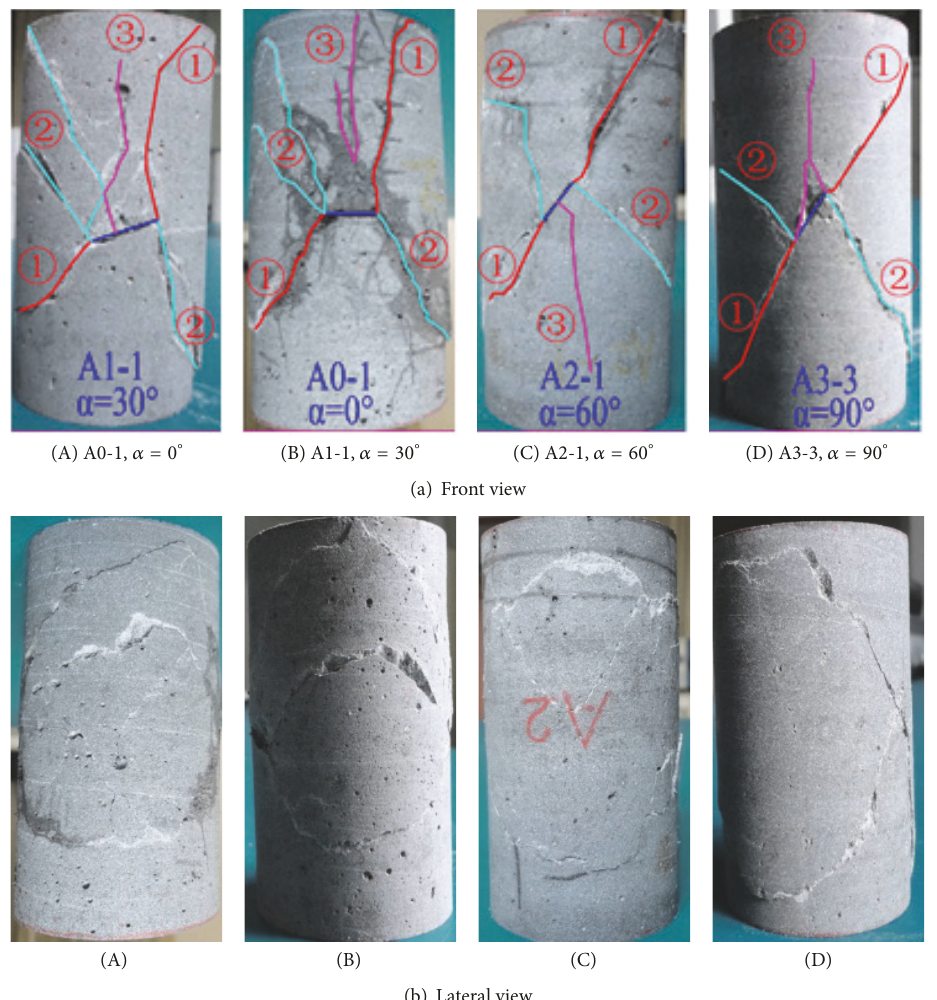
Figure 6: Fracture modes of specimens with different joint